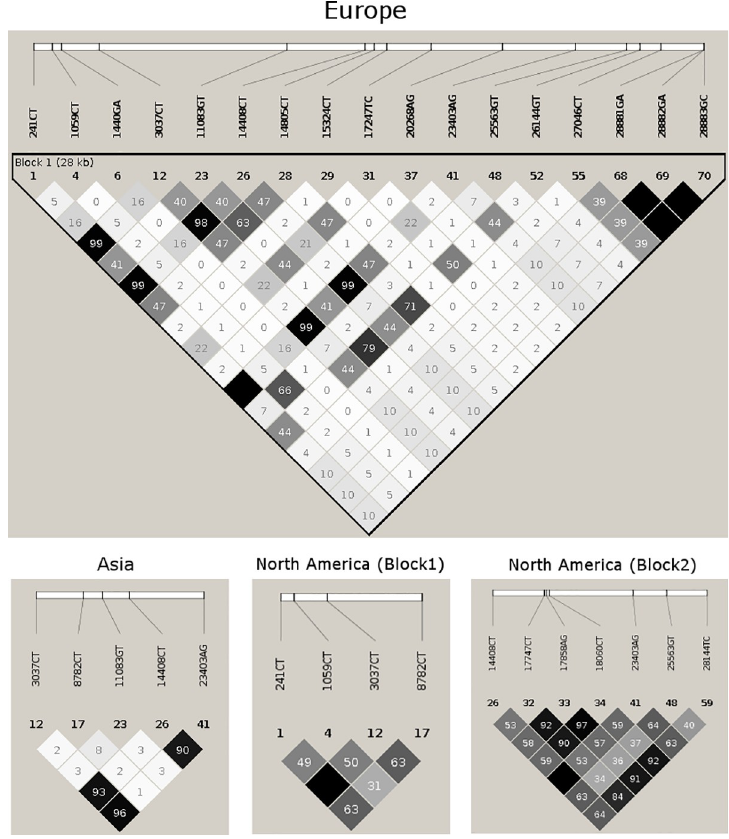
Fig 4. Estimation of haplotype blocks in continental samples. Haplotype block estimation and extent of linkage disequilibrium observed between variants in Asia, Europe, and North America, identified a single block with different lengths in Asia and Europe, while in North America two blocks were